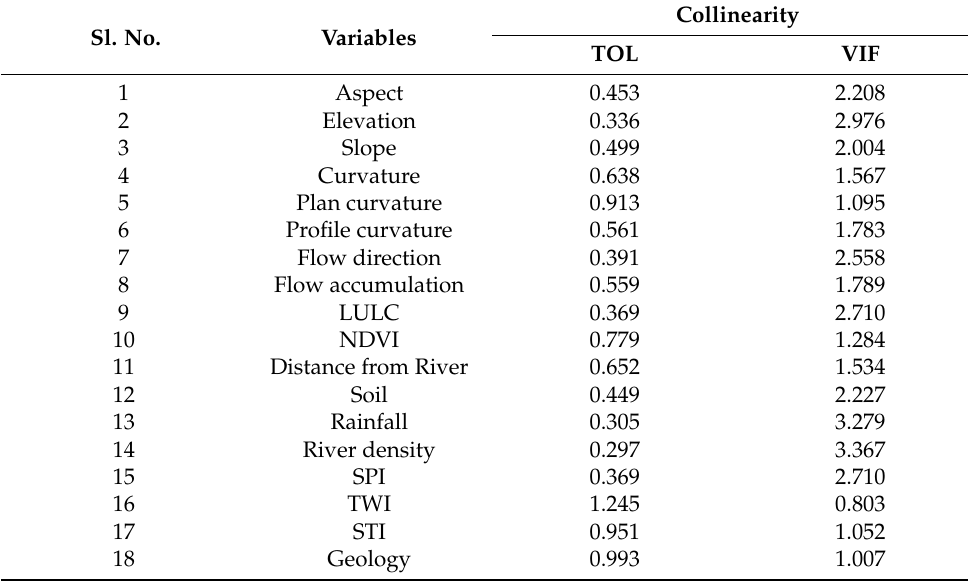
Table 1. Multicollinearity